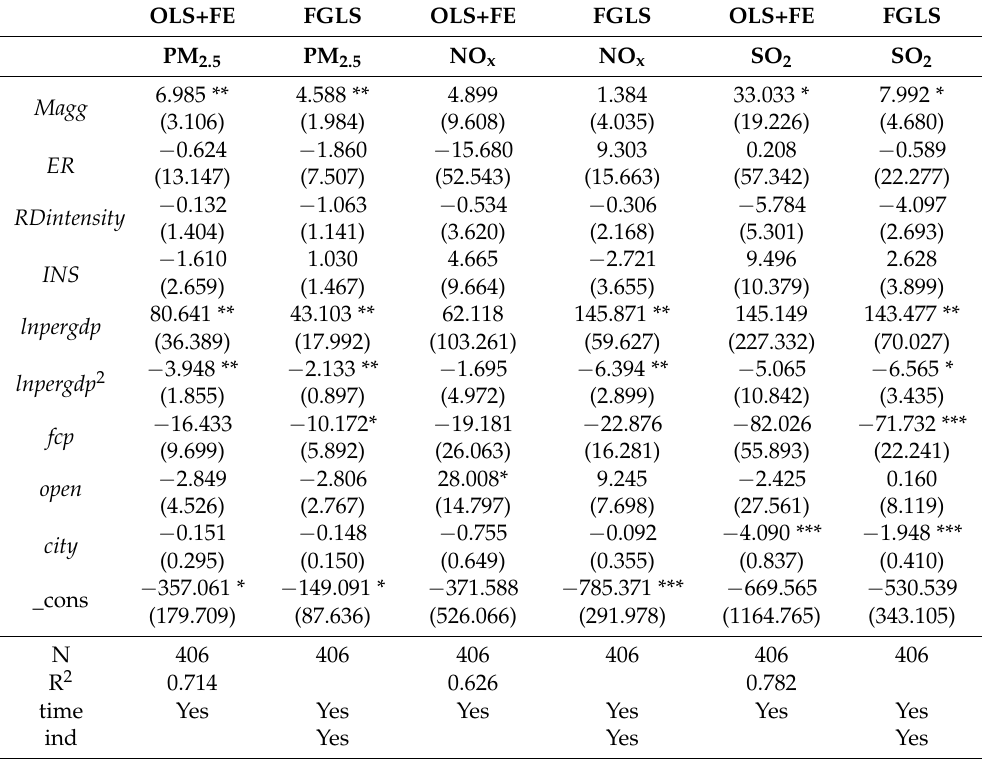
Table 3. Baseline regression of the effect of the agglomeration of manufacturing on air pollution.